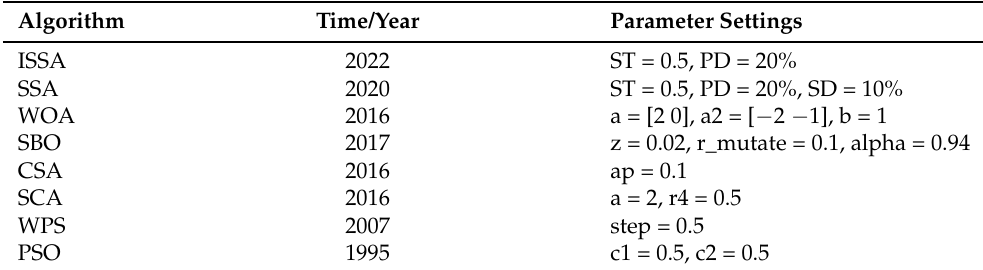
Table 5. The parameter settings of the chosen optimization algorithms.